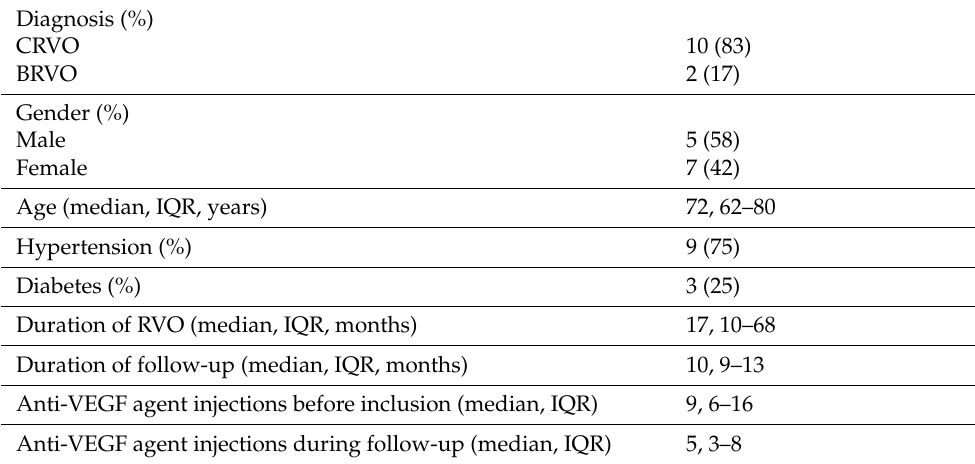
Table 1. Demographic and clinical characteristics at inclusion in the